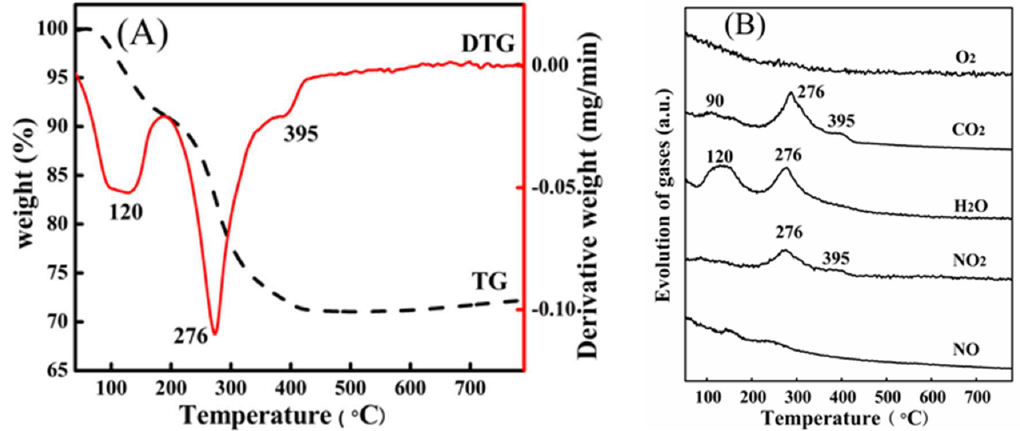
Figure 3. Results of TG and DTG studies ( A ) combined with MS analysis ( B ) for the NiFe-LDH sample.